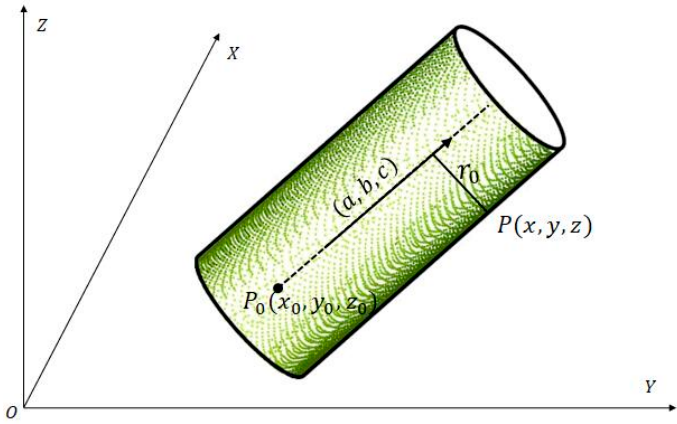
Figure 2. Parametric model of the cylinder.